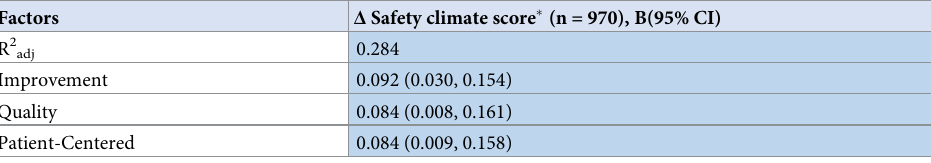
Only factors significant in at least one of the models are presented. � Adjusted for unit size and score SAQ